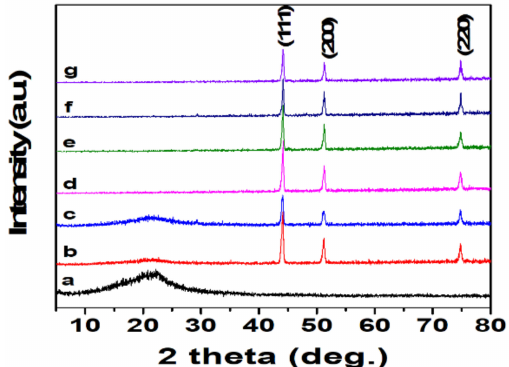
Figure 2. XRD patterns of ( a ) glass plate and double faced adhesive tape; ( b ) Cu foam; ( c ) Cu foam etched by FeCl 3 ; ( d – g ) etched Cu foams modified by EE, DE, HDE, and ODE,